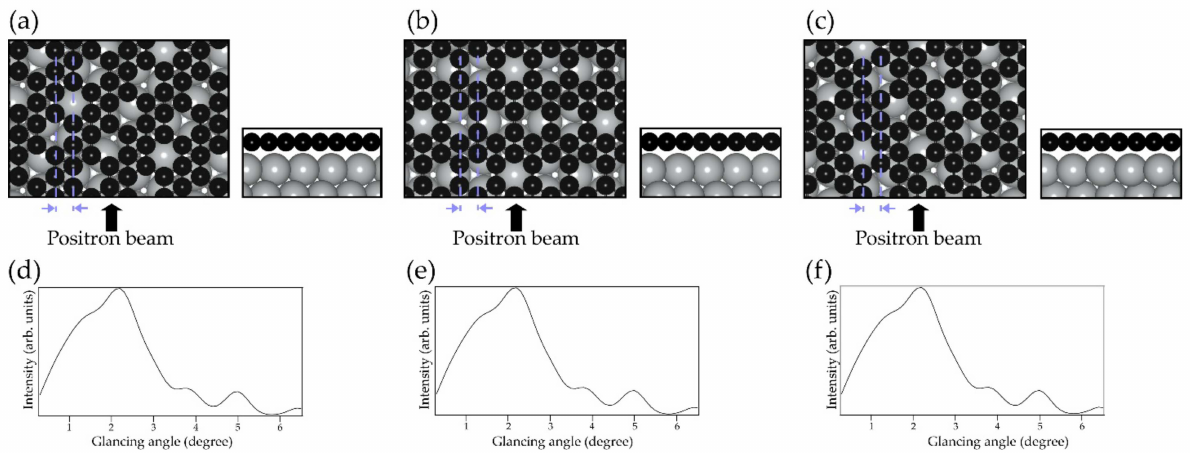
Figure 2. ( a – c ) Structure of each of the three domains of χ 3 -borophene grown on different directions to Ag(111), viewed from the top and side. ( d – f ) The RCs of ( a – c ), respectively. The shape of the RCs was the same for